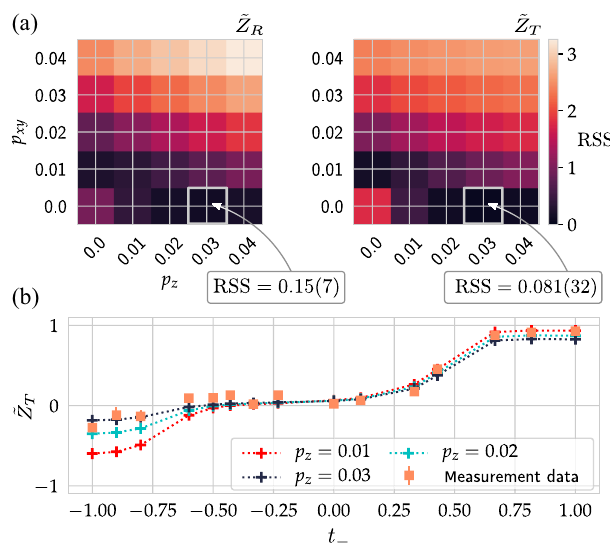
˜ Z =T considering an imperfectly cooled R